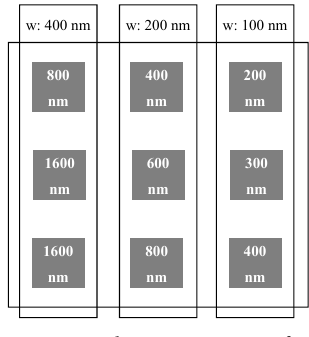
Fig. 1 . Schematic patterns of stamp